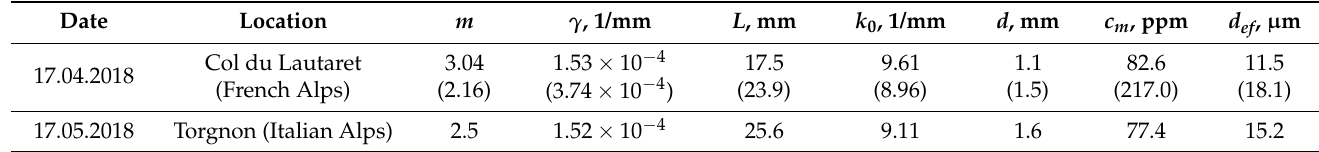
Table 5. The retrieved spectral mass absorption coefficient (MAC) of dust as retrieved with or without gains by SICE as well as measured in [41,51] .